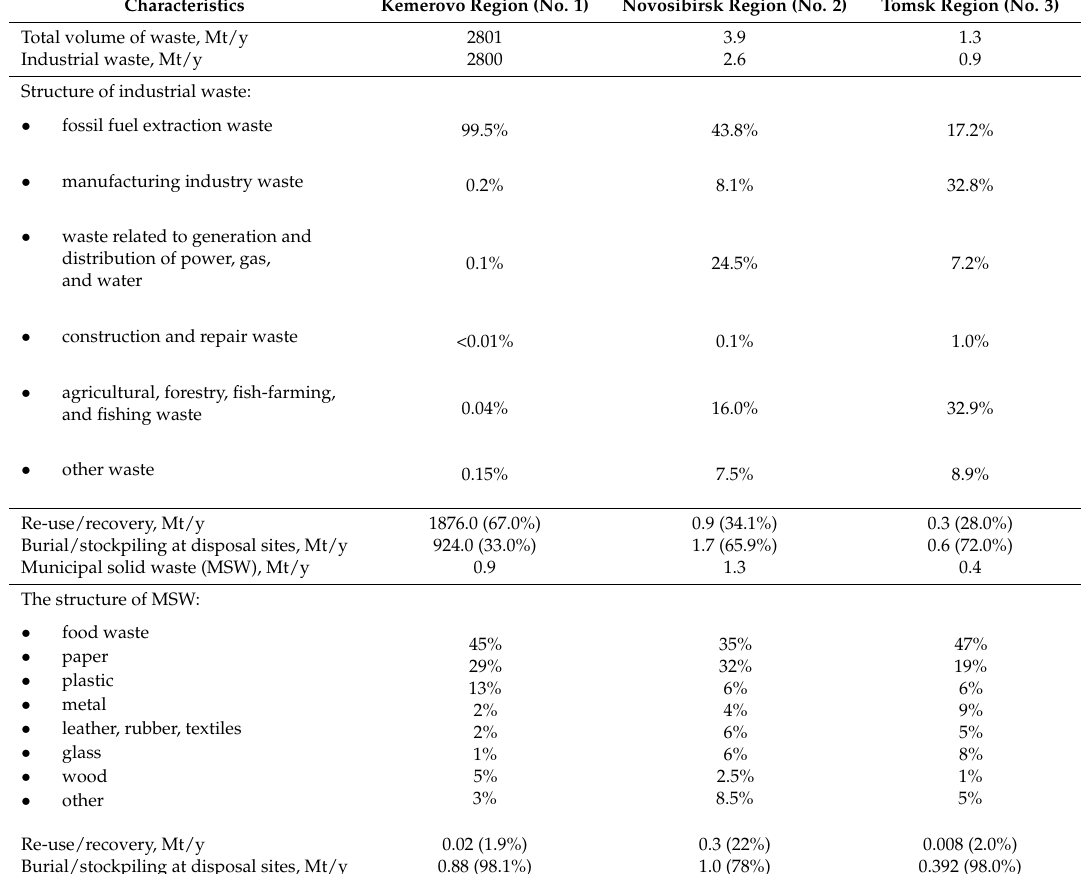
Table 4. Characteristics of waste by regions